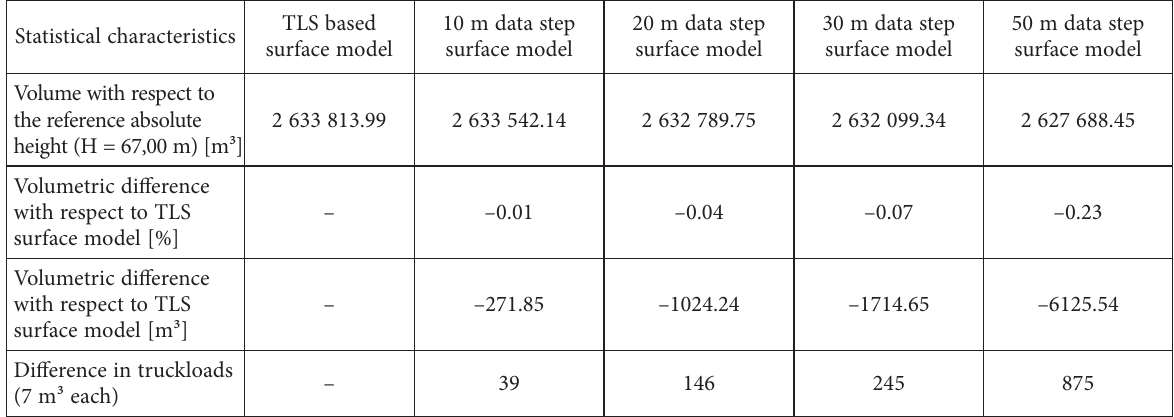
Table 3. Results of volumetric calculations on the example of semi - coke landfill ash-hill Statistical